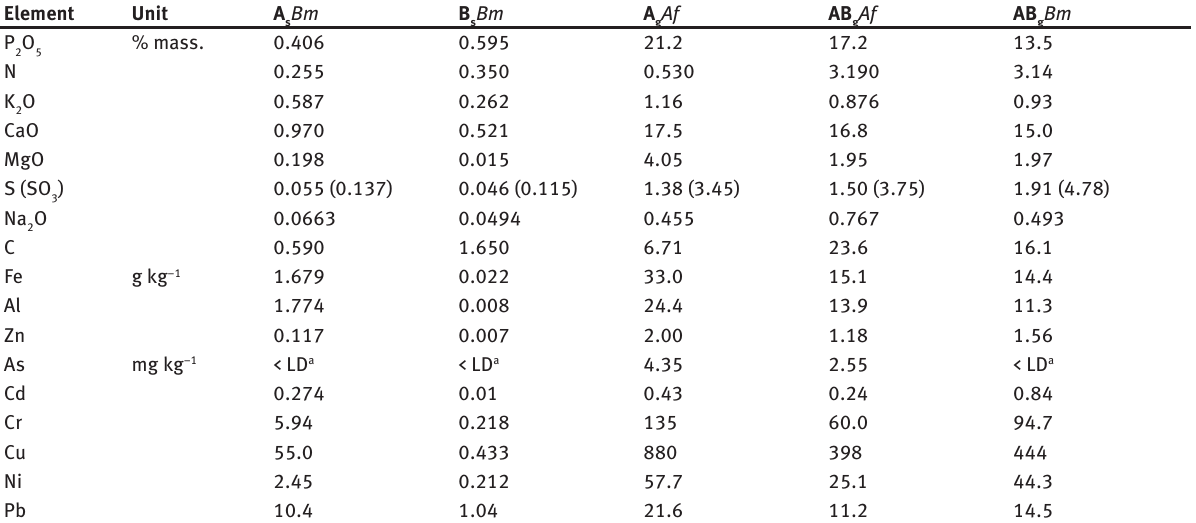
Table 2: Elemental composition of biofertilizers. Element